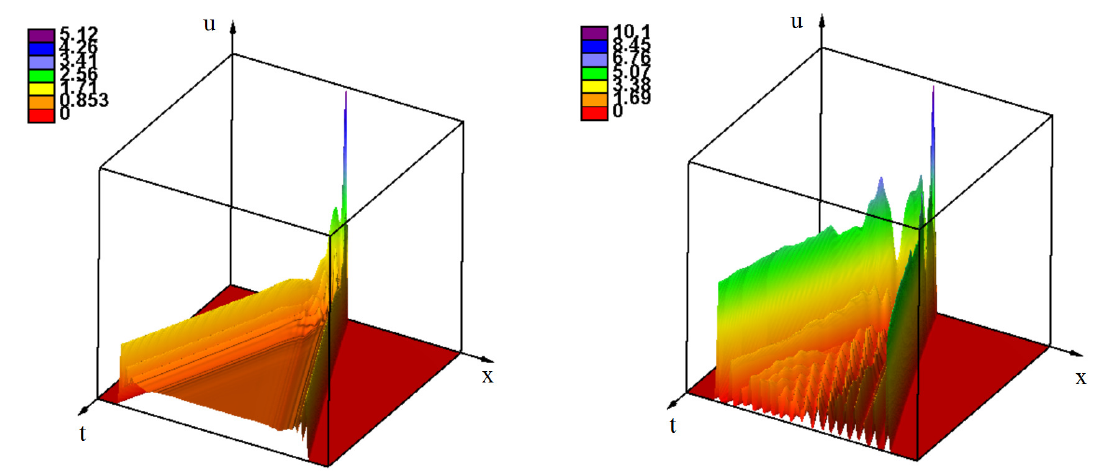
Figure 5. Numerical simulations of Equation (1) with f ( u ) = k 1 u . If the solution u − is stable, then there is a [ w + , w − ] -wave propagating with a constant speed and profile with possible spatial oscillations independent of time ( left ). If this solution is unstable, then this wave is followed by spatiotemporal oscillations ( right ). The values of parameters: r = 1, q = 1, L = 2, D = 10 − 5 , k 1 = 0.9, τ = 3, N = 0.25, τ = 2 ( left ), τ = 4 ( right ), t =